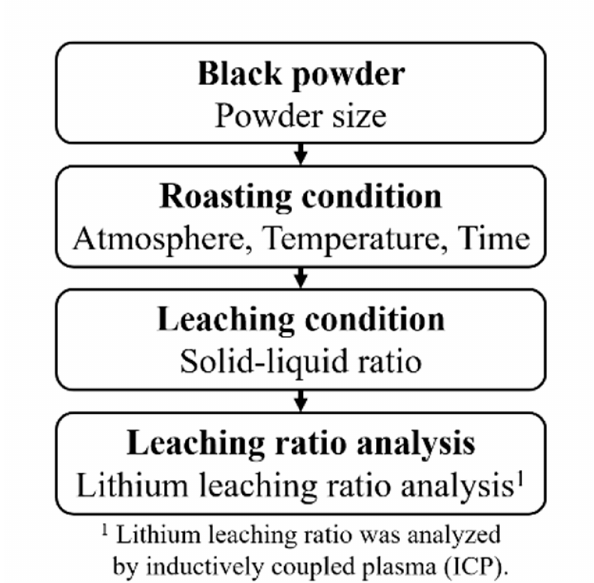
Figure 2. Selective lithium leaching experimental process.